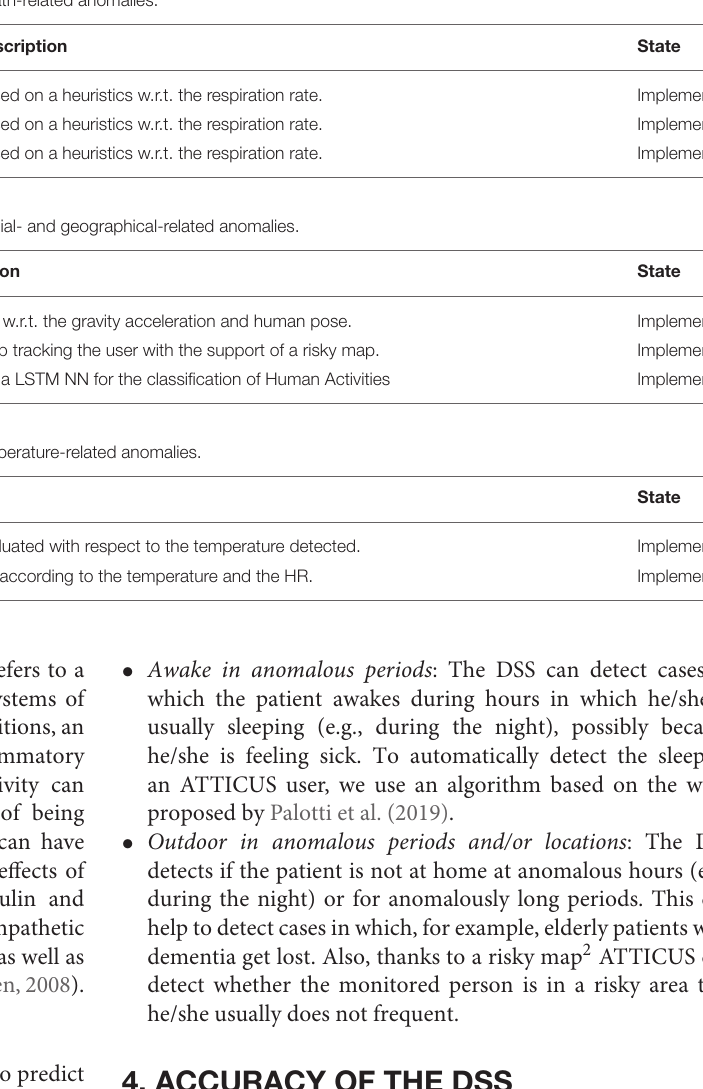
TABLE 2 | Approaches integrated in ATTICUS for the detection of breath-related anomalies.